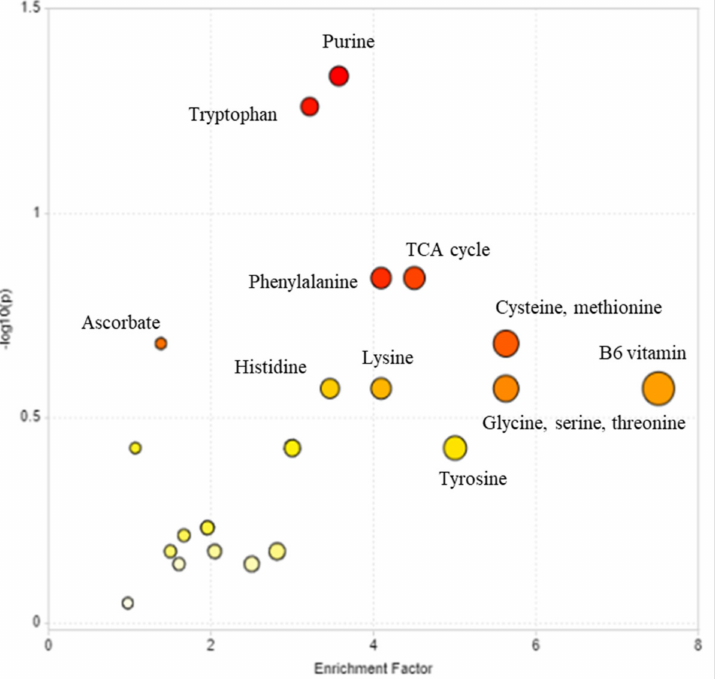
Figure 3. Pathway enrichment analysis of metabolites varying in the metabolome of Black Pepper ( Piper nigrum L.) leaves challenged with Phytophthora capsici . Metabolites exhibiting significant variation in leaves (Figure 2) were assessed for pathway enrichment. Pathways showing the highest enrichment and metabolomic impact are